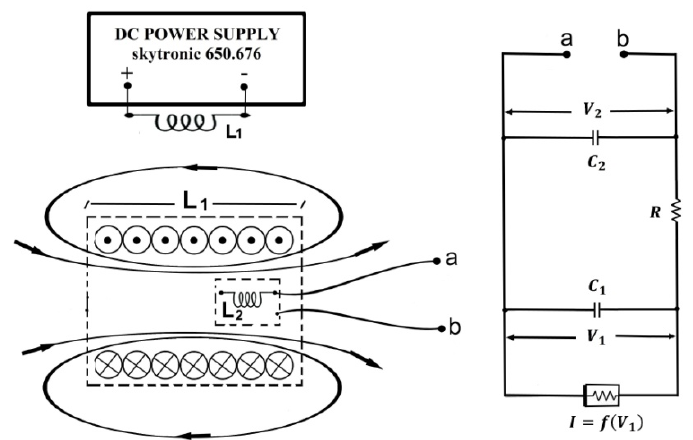
Figure 1. Chua’s circuit ( right plot ) with the inductor L 2 = 18 mH placed in the coil L 1 = 85.1 mH powered by DC ( left plot ), capacitors C 1 = 10 nF and C 2 = 100 nF, the nonlinear Chua diode with piecewise-linear characteristic I = f ( V 1 ) and variable resistor R